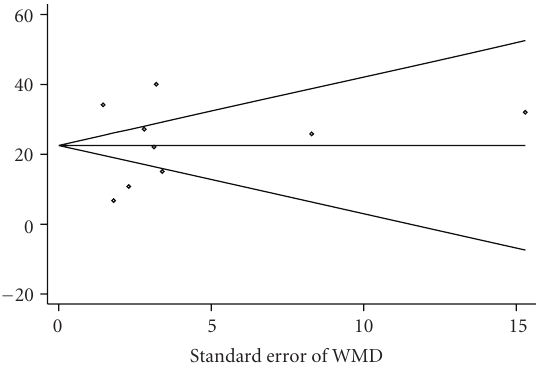
Figure 3: Begg’s funnel plot with pseudo 95% confidence limits.